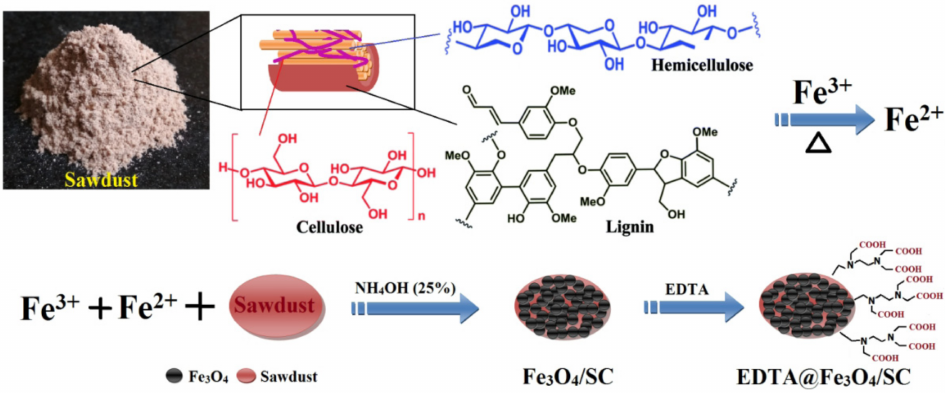
Figure 6. Scheme for synthesis of Fe 3 O 4 /SC and EDTA@Fe 3 O 4 /SC [169]. Reproduced with permis- sion from Kataria et al., Elsevier B.V. Eng.; published by the chemosphere